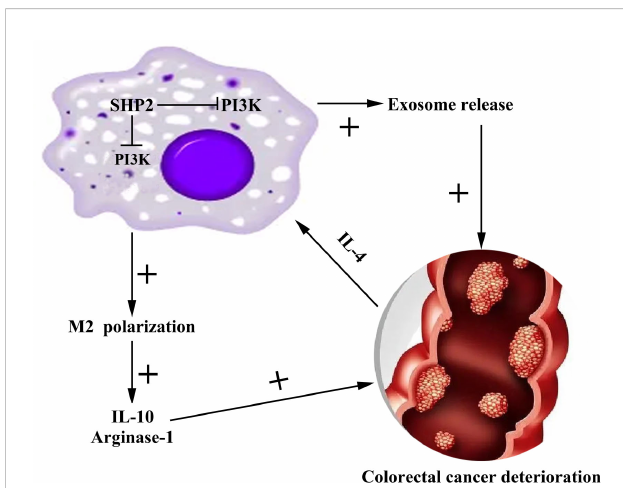
FIGURE 9 Mechanism diagram of SHP-2 regulating CRC through TAMs. Src homology region 2 domain-containing protein tyrosine phosphatase- 2; CRC, colorectal cancer; TAMs tumor-associated